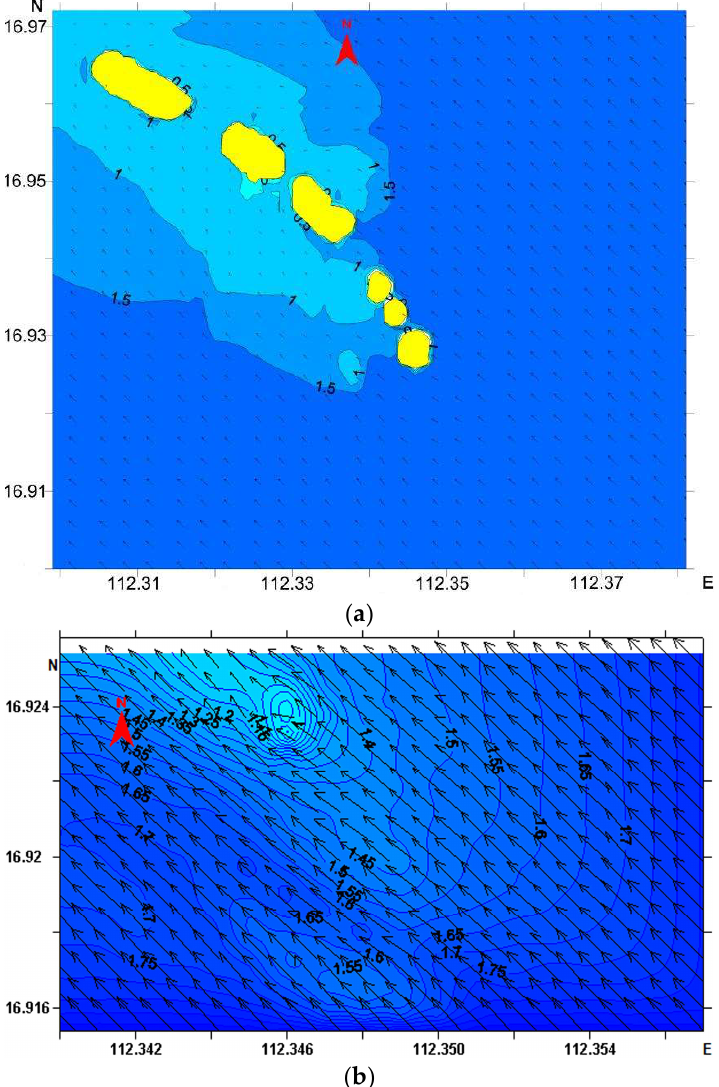
Figure 6. Wave vector diagram in the dominated wave direction (SSE) around the Qilianyu ( a ) and Wave vector diagram in the dominated wave direction (SSE) around the newborn sandbank ( b ).